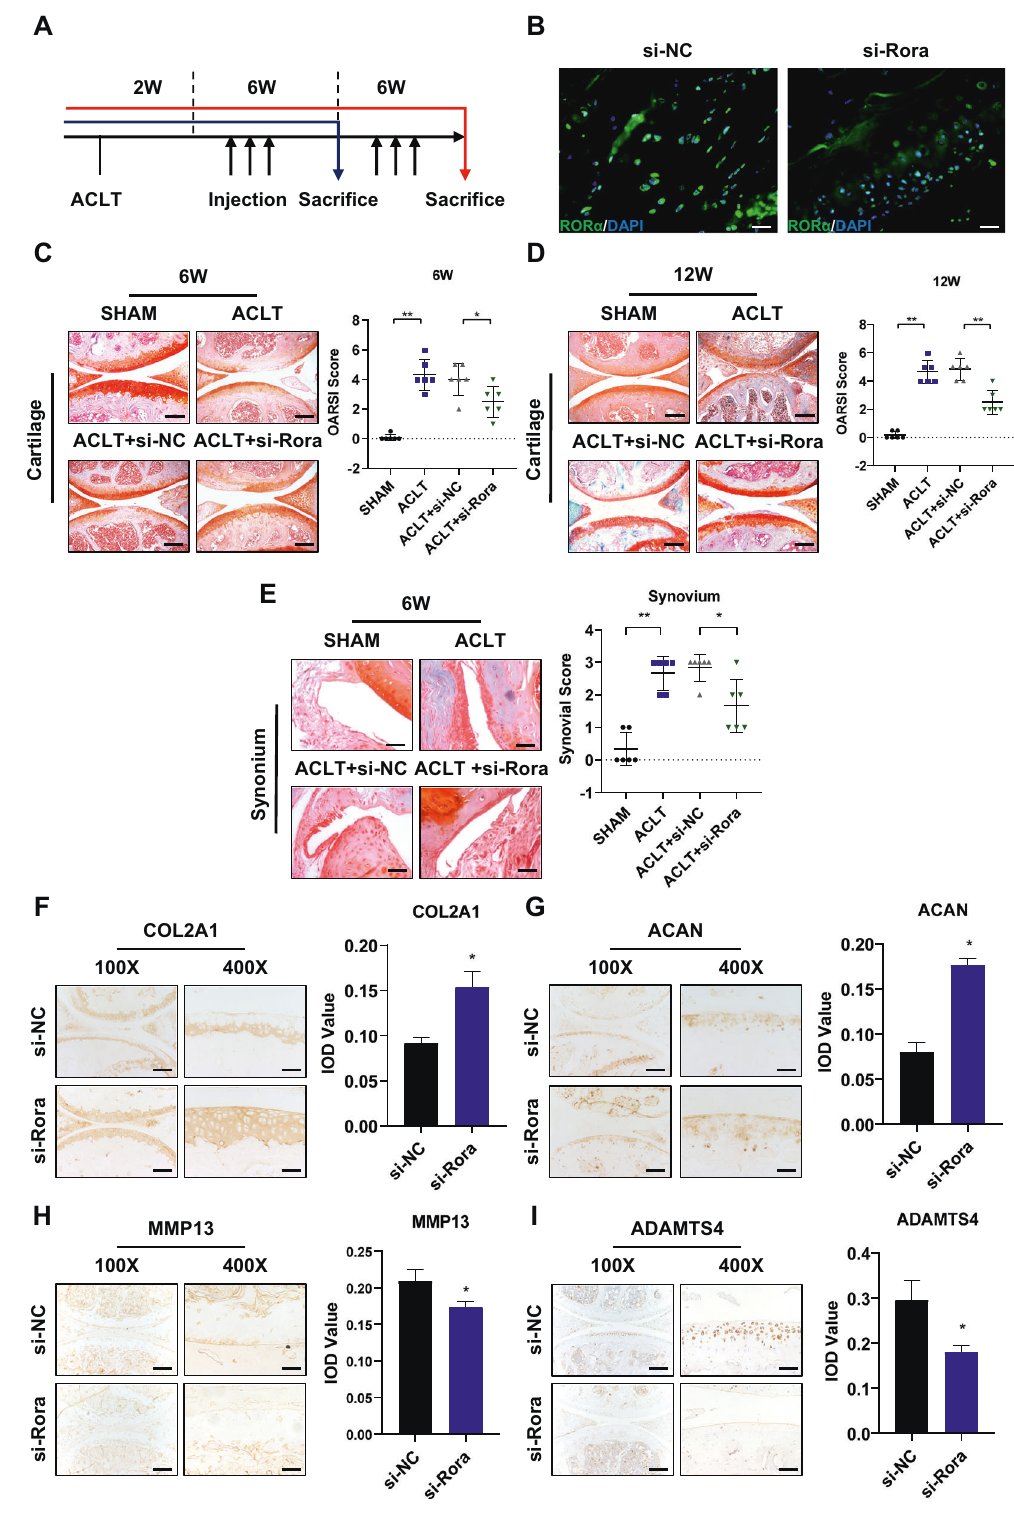
relatively unchanged, whereas the expression of phosphorylated STAT3 (Tyr705) increased progressively with OA severity in patients (Fig. 5A). The result is consistent with previous research, which showed IL-6/STAT3 pathway activation is positively associated with cartilage damage [17]. Next, we examined whether the expression of phosphorylated STAT3 is